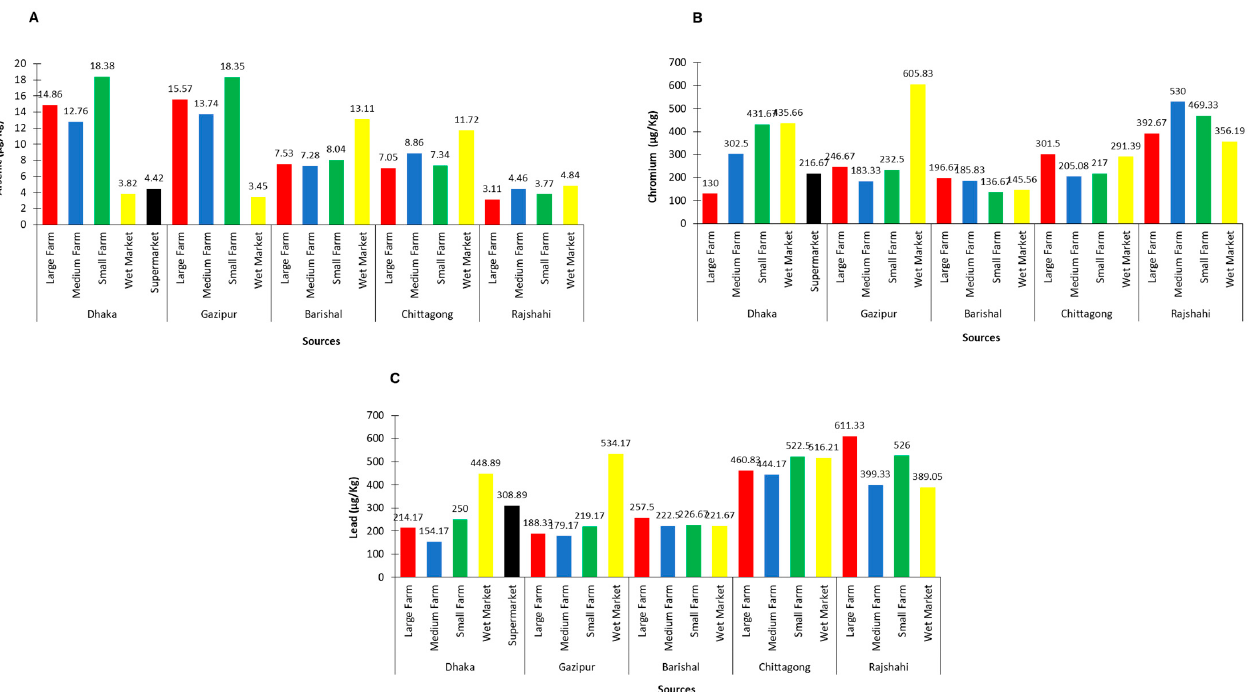
Figure 6. Concentration of heavy metals residue. ( A ) Arsenic, ( B ) chromium, ( C ) lead in broiler meat, bone and edible composite collected from various large farms, medium farms, small farms, broiler wet meat markets and supermarkets in Dhaka.